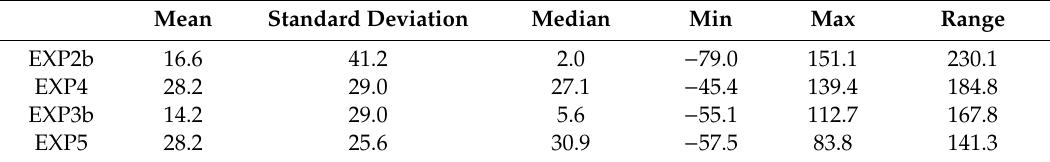
Table 16. SHF (W m − 2 ) simulated by UTOPIA and NOAH, initialized with GLDAS, at the CO station. Mean Standard Deviation Median Min Max Range EXP2b